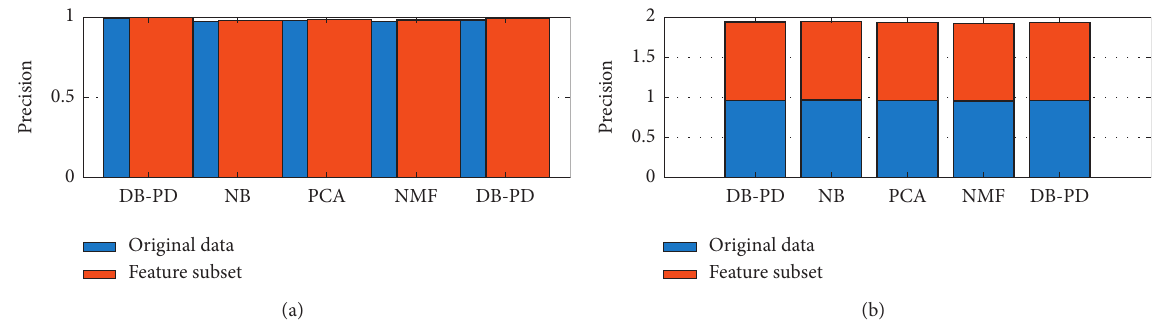
Figure 8: Analysis of feature association mining accuracy based on the original dataset and feature